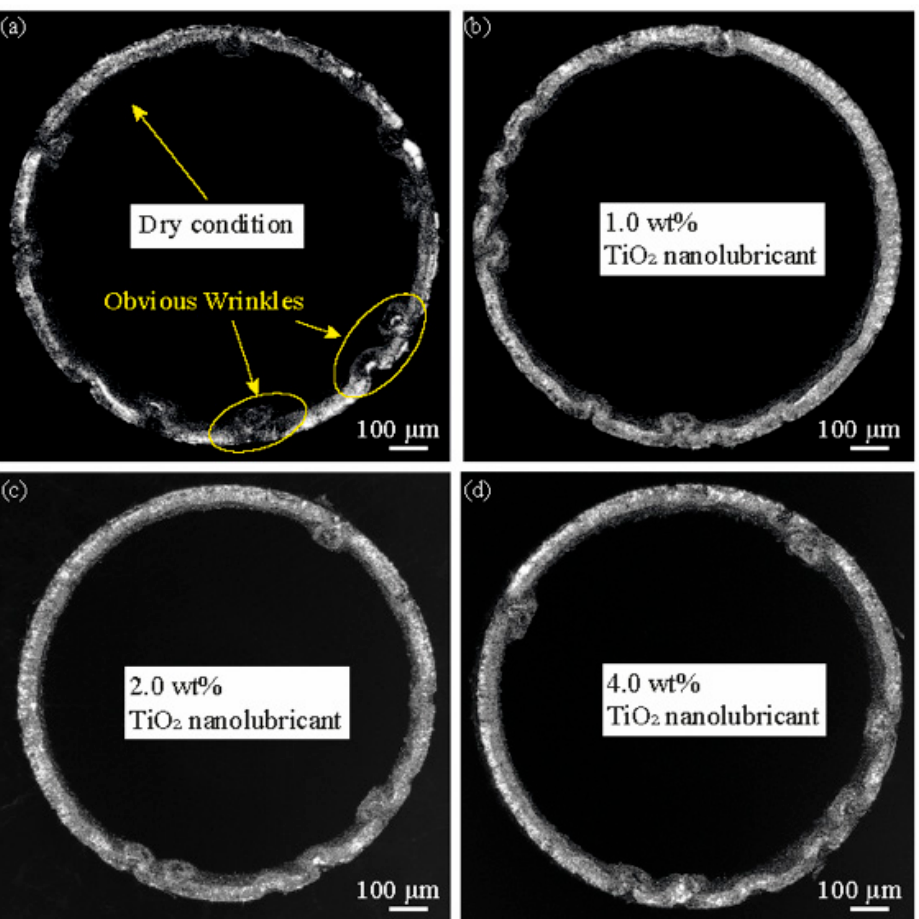
Figure 8. Mouth view of drawn cups from different lubrication conditions: ( a ) dry; ( b ) 1 wt% TiO 2 lubrication; ( c ) 2 wt% TiO 2 lubrication; and ( d ) 4 wt% TiO 2 lubrication.